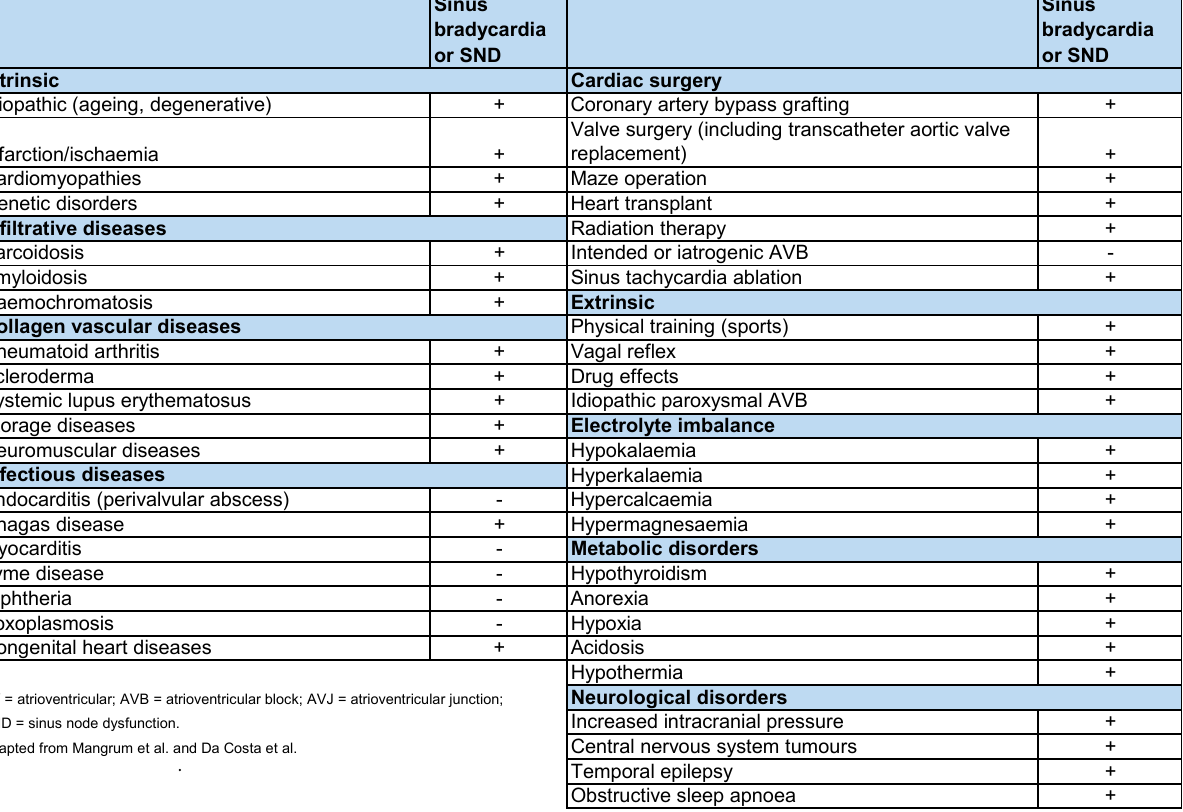
Figure 5. Intrinsic and extrinsic causes of bradycardia [16].